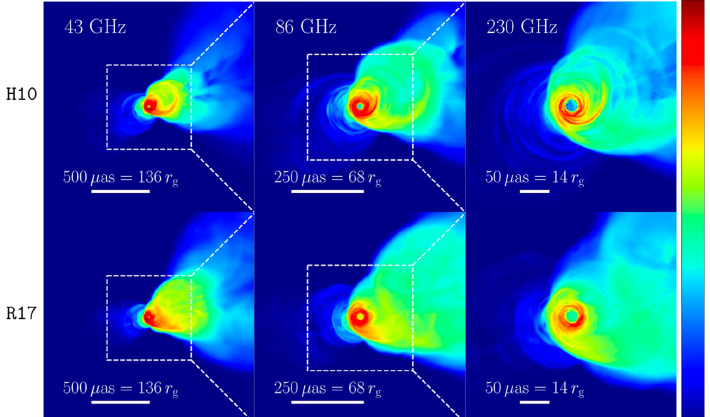
Figure 7. Logarithmic scale radiation images of two-temperature GRMHD simulations of a MAD torus with electron heating prescription at 43 ˜GHz ( left ), 86 ˜GHz ( middle ), and 230 ˜GHz ( right ). Snapshots were observed at an inclination angle of 17 degrees with respect to the simulation south pole and rotated 108 degrees counterclockwise, in order to fit the observed jet orientation. Figure is reproduced with permission from Chael et al. MNRAS, 486, 2873 (2019)